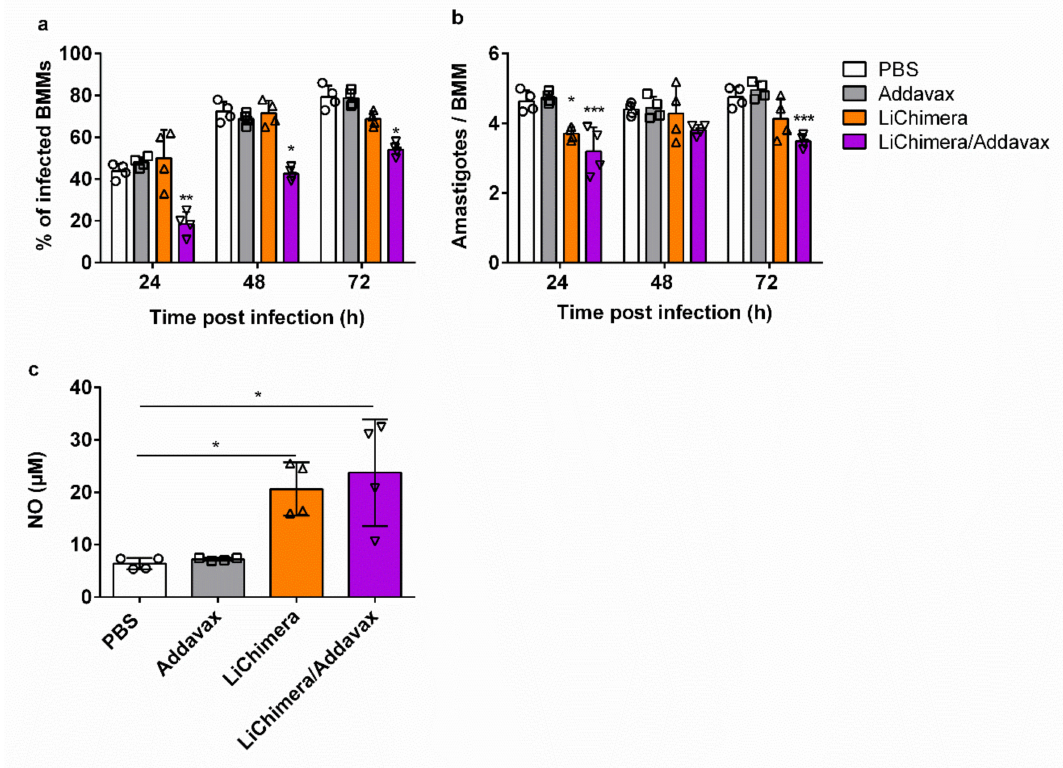
Figure 9. LiChimera vaccination triggers innate responses. The bone marrow-derived macrophages (BMMs) were di ff erentiated from the bone marrow of vaccinated and non-vaccinated mice two weeks post boosting injection followed by in vitro infection with L. infantum parasites. At 24, 48, and 72 h post challenge, cells were Giemsa stained for determination of ( a ) percentage of infected BMMs and ( b ) determination of intracellular parasite numbers; ( c ) Detection of NO levels 48 and 72 h post challenge in culture supernatants with Griess reaction. Data are expressed as means ± s.d. of triplicate cultures from n = 4 mice per group. Circles, boxes, triangles and reverse triangles represent individual animals from PBS, Addavax, LiChimera or LiChimera / Addavax group, respectively. Significant di ff erences between groups are indicated with asterisks measured by one-way ANOVA and Tukey’s multiple comparison tests. * p < 0.05, ** p < 0.01, and *** p <